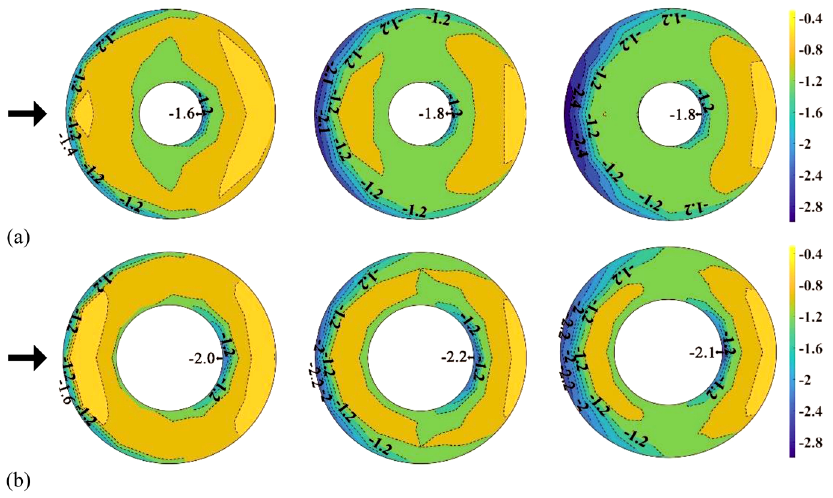
Figure 11. Distribution of C pe,min ( H / D = 0.1, 0.3 and 0.5): ( a ) open ratio of 30% and ( b ) open ratio of 50%.